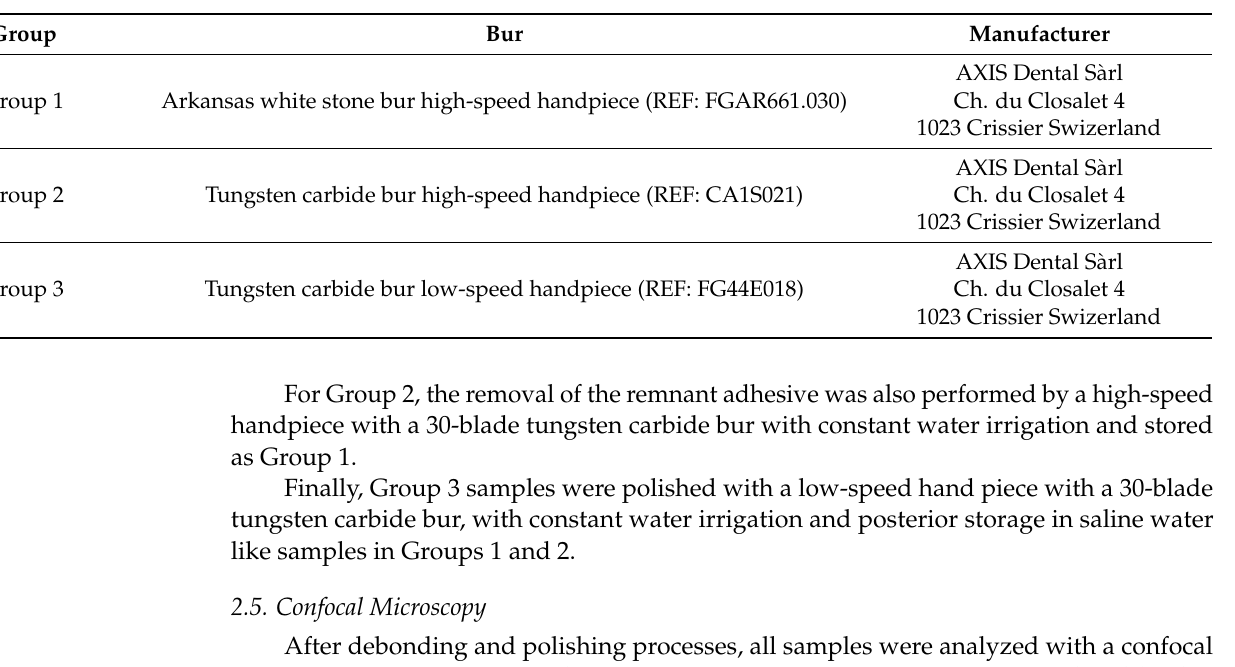
Table 2. Polishing system of each group after